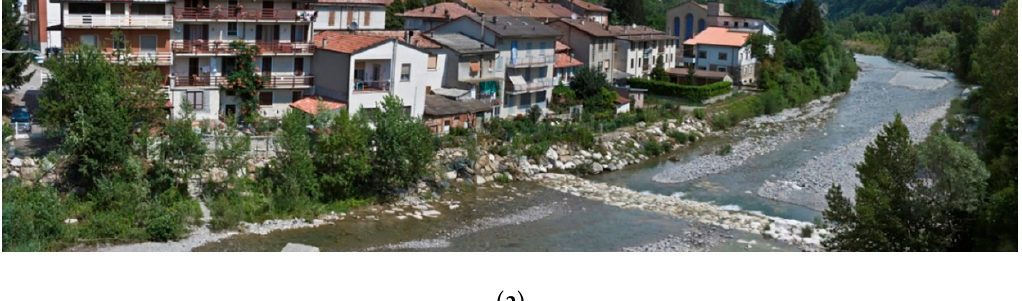
Figure 12. Bathymetry of the Nure watershed and investigated cross sections.